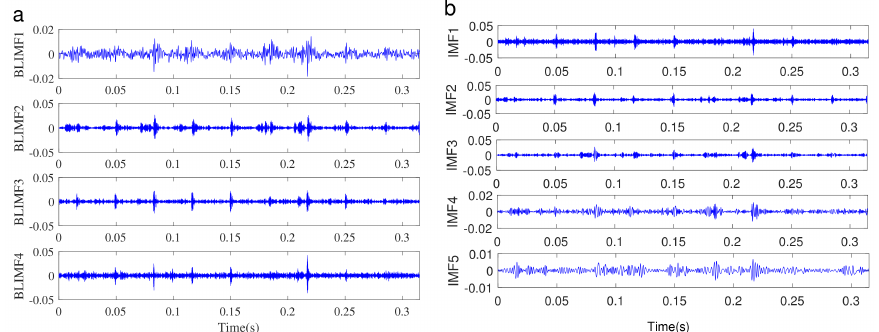
Figure 20. The decomposed BLIMFs using VMD ( a ) and IMFs using EMD ( b ) from the signal of the gear with tooth surface